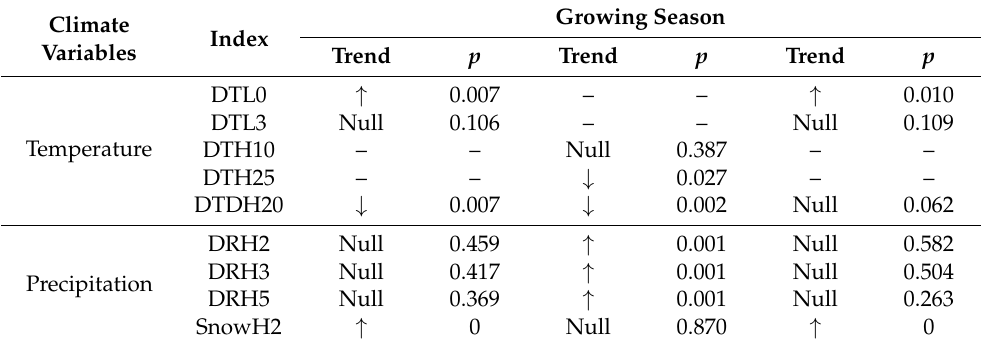
Table 5. Variability in the precipitation and temperature metric indices with ecological relevance along the altitude gradient. The change trends and coefficients of the linear fitting model are shown with a significance level of p < 0.05. The sign “ ↓ ” means a significant decrease; “ ↑ ” means a significant increase; “Null” means no significant change; and “–” means no analysis of the index was conducted during the given